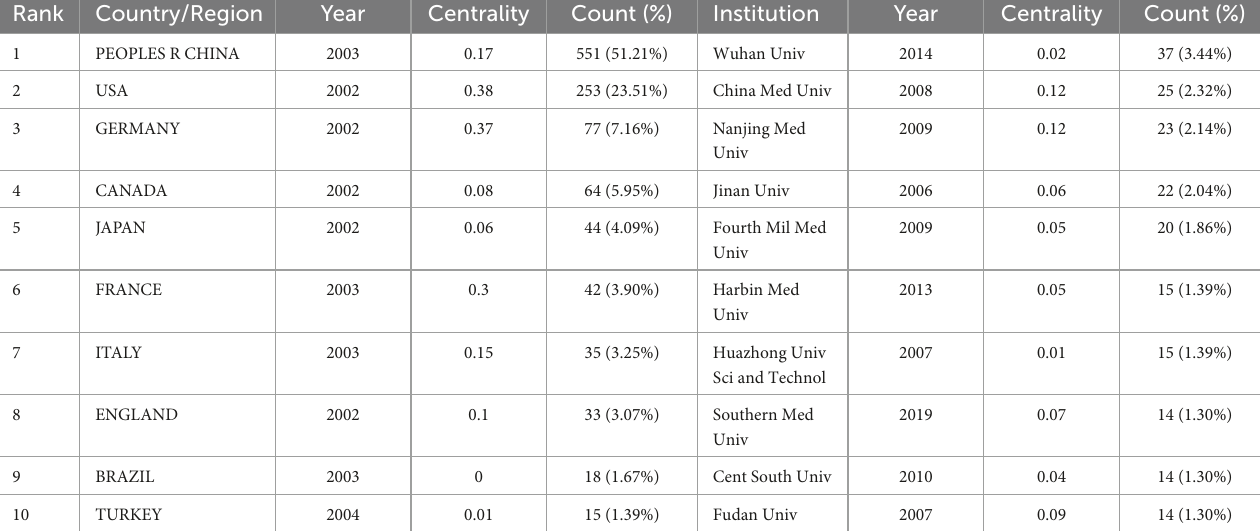
TABLE 1 The top 10 countries/regions and institutions related to SIMD.